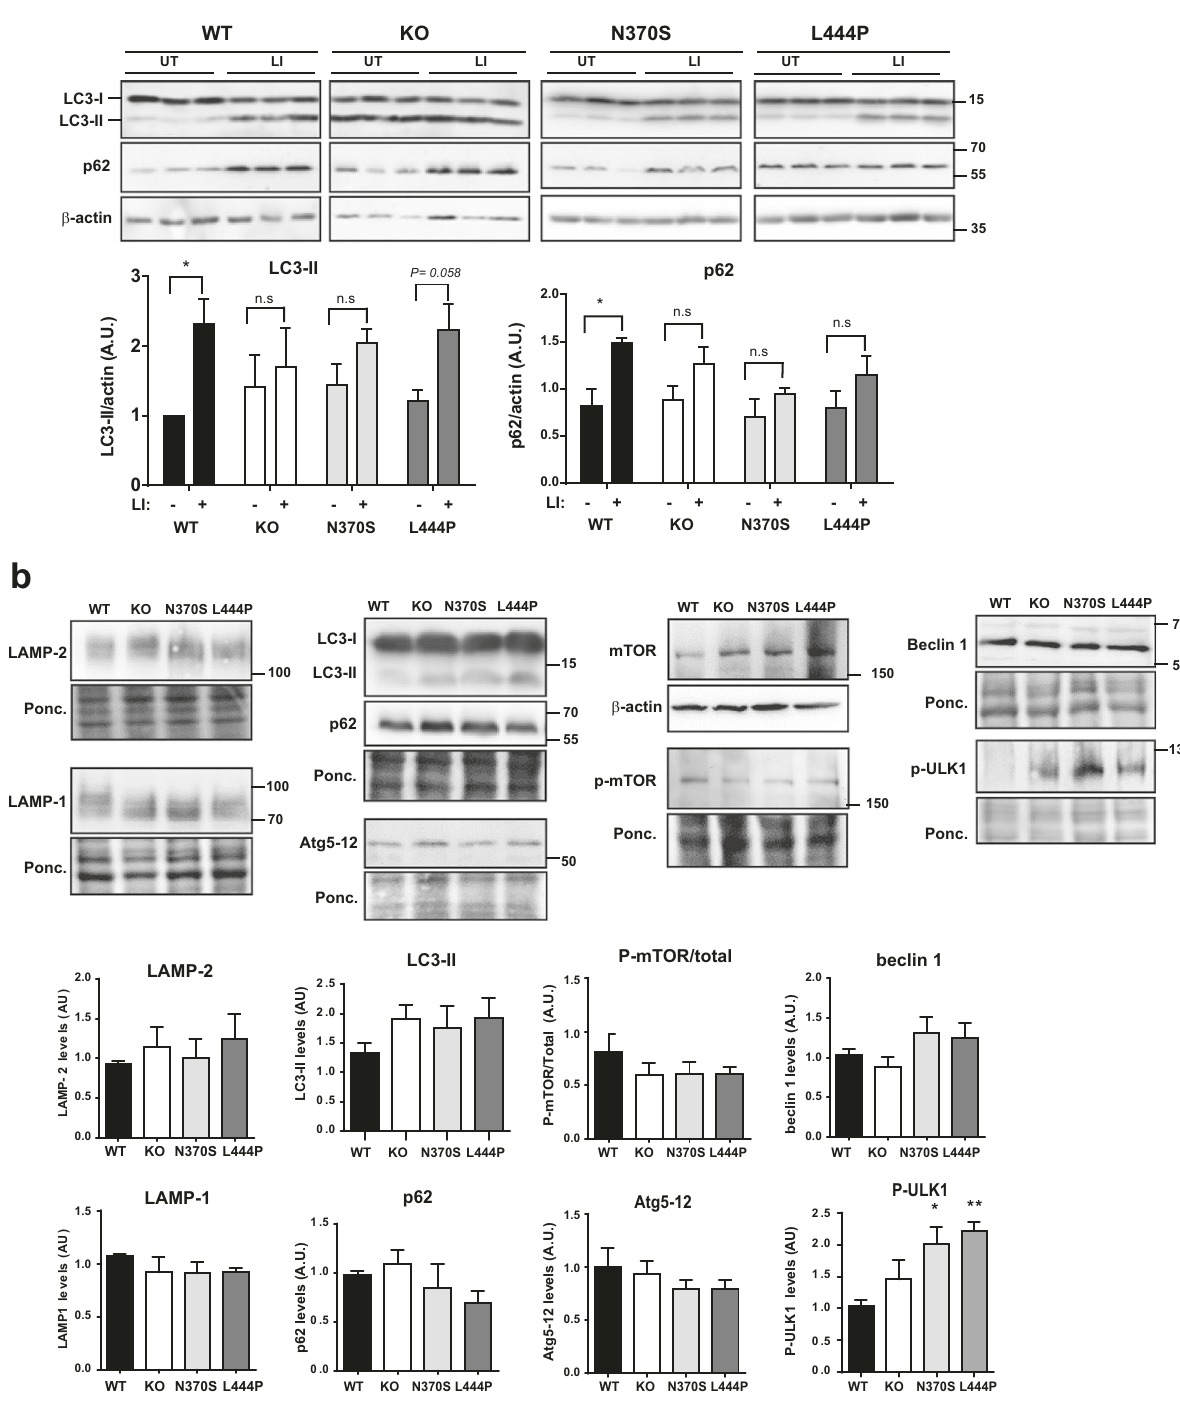
Fig. 5 Mutant GBA causes alterations in macroautophagy. a Autophagic fl ux: immunodetection and quanti fi cation of LC3-II and p62 in the presence and absence of the lysosomal inhibitor (LI) 60 µM chloroquine. Results are presented as mean ± s.e.m. values of three independent experiments. Statistical signi fi cance was established at * p < 0.05 compared to untreated conditions by two-tailed unpaired Student ’ s t -test. b Representative immunoblots and quanti fi cation of autophagic and lysosomal markers. In all panels, results are presented as mean ± s.e.m. values of at least six independent experiments. Statistical signi fi cance was established at * p < 0.05, ** p < 0.01, compared to WT samples after one-way ANOVA followed by Tukey ’ s multiple comparisons